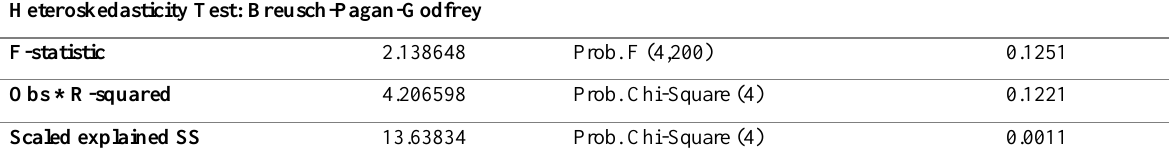
Table 5: Normality Test Output